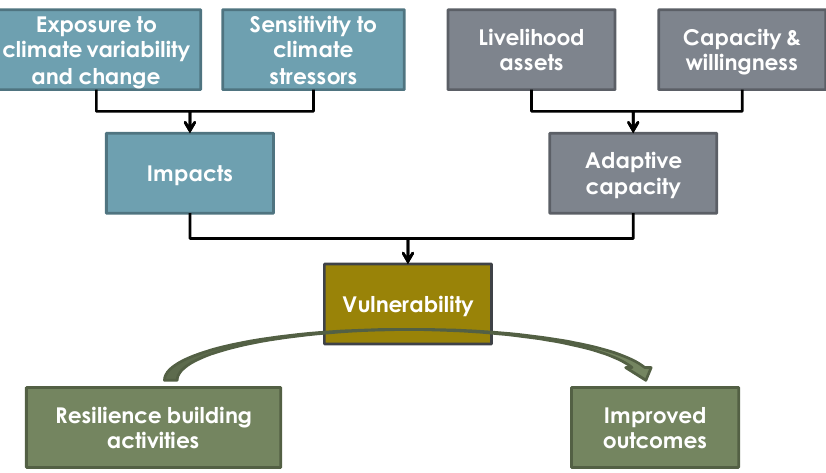
Figure 1. Conceptual framework for climate resilience in the